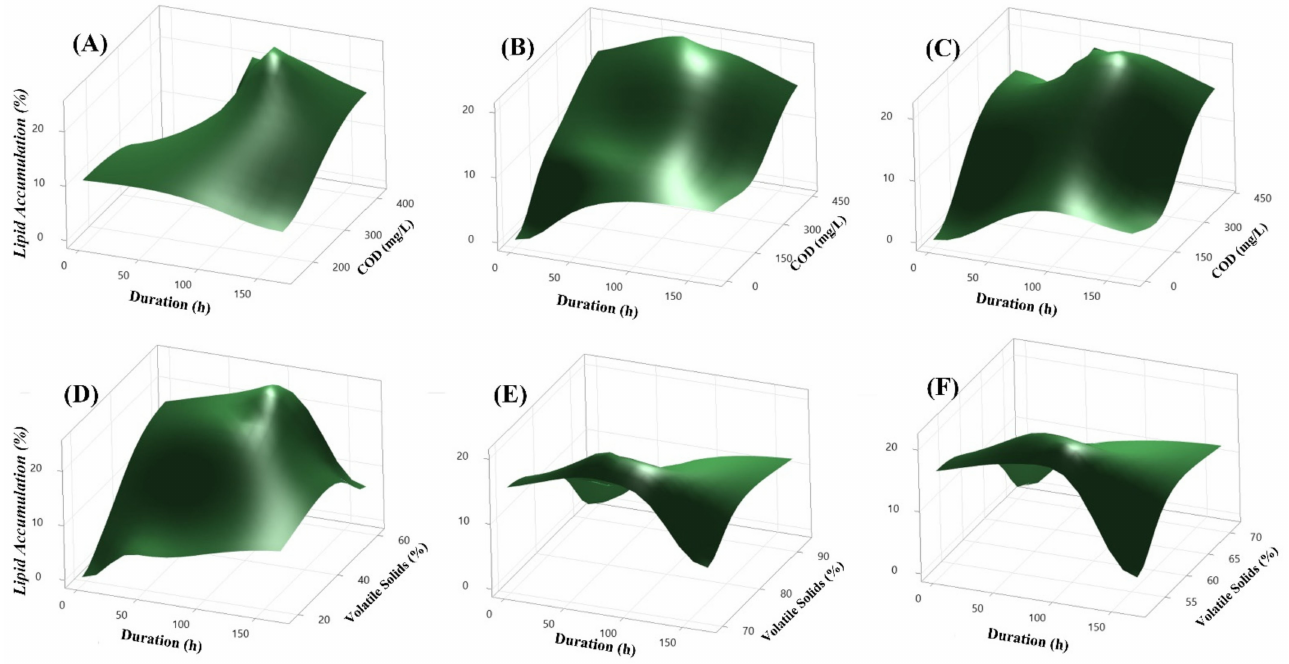
Figure 5. Surface Plot of Lipid Accumulation by bacterial isolate KM10 in different types of waste vs. COD and Volatile solids: ( A ) COD in AW, ( B ) COD in MW, ( C ) COD in OW, ( D ) Volatile solids in AW, ( E ) Volatile solids in MW and ( F ) Volatile solids in